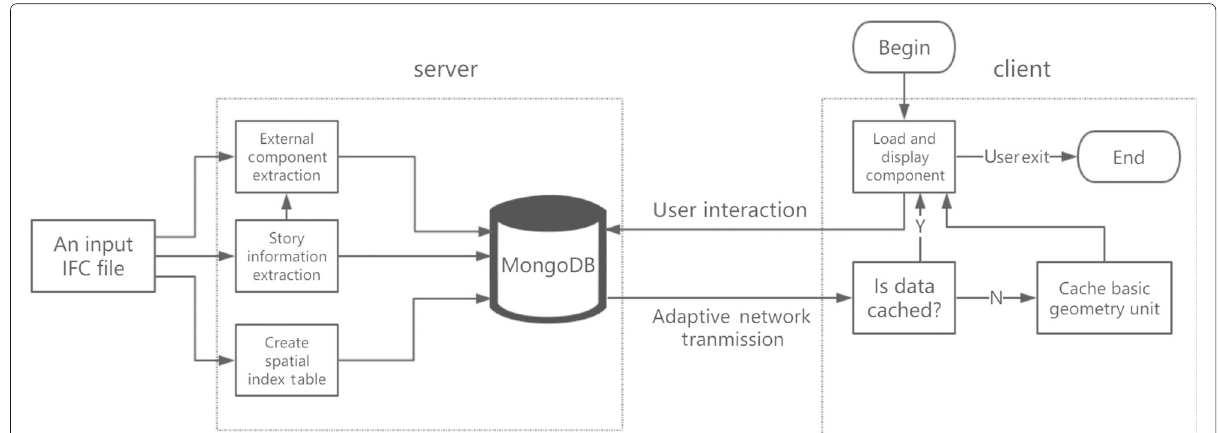
Fig. 1 Structure diagram of the proposed